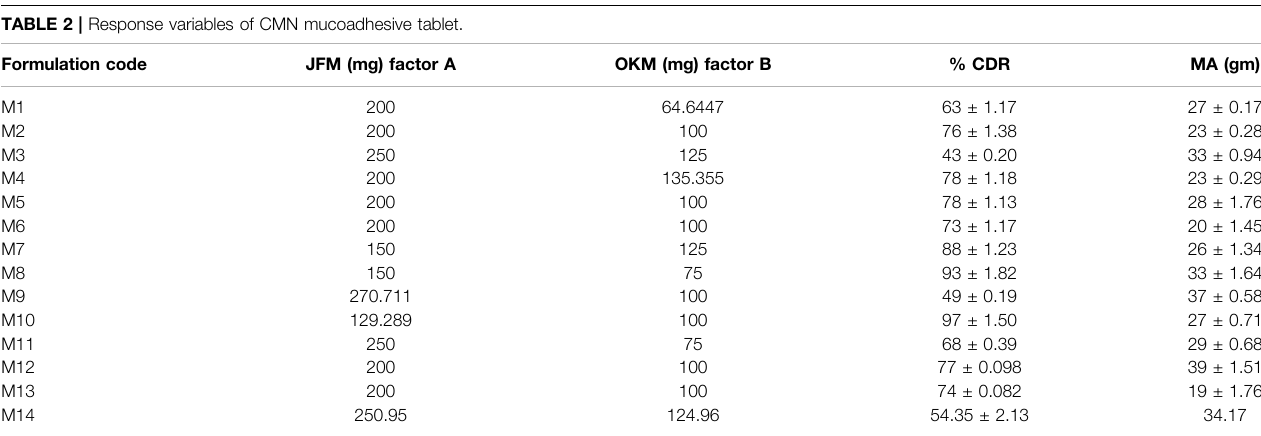
TABLE 2 | Response variables of CMN mucoadhesive tablet. Formulation